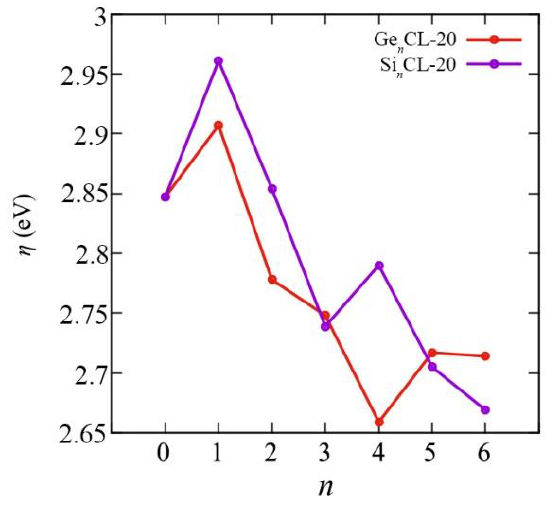
Figure 9. The hardness η versus the number of Si-/Ge-atoms n in the Si n CL-20/Ge n CL-20 molecules for the most thermodynamically stable configurations obtained at the DFT/B3LYP/6-311(d,p) level of theory.